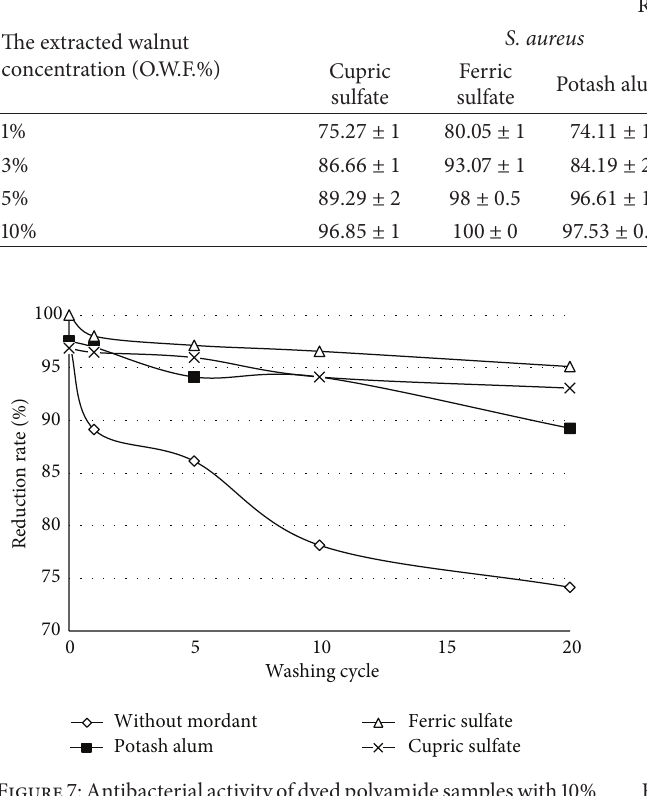
Figure7:Antibacterialactivityofdyedpolyamidesampleswith10% walnut dye against S. aureus after laundering.